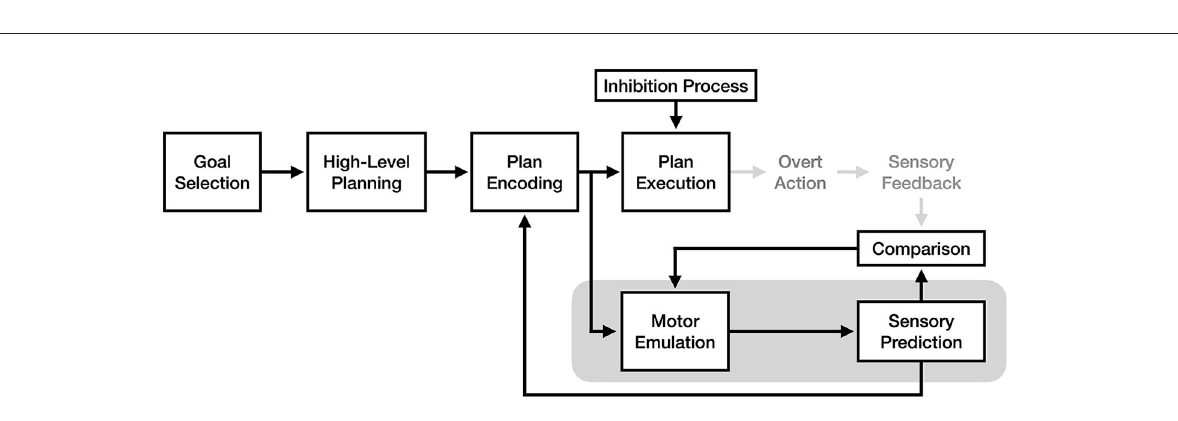
FIGURE3 The process of motor imagery as proposed by motor emulation theory. The stages of motor execution thought to be responsible for the experience of motor imagery are enclosed in